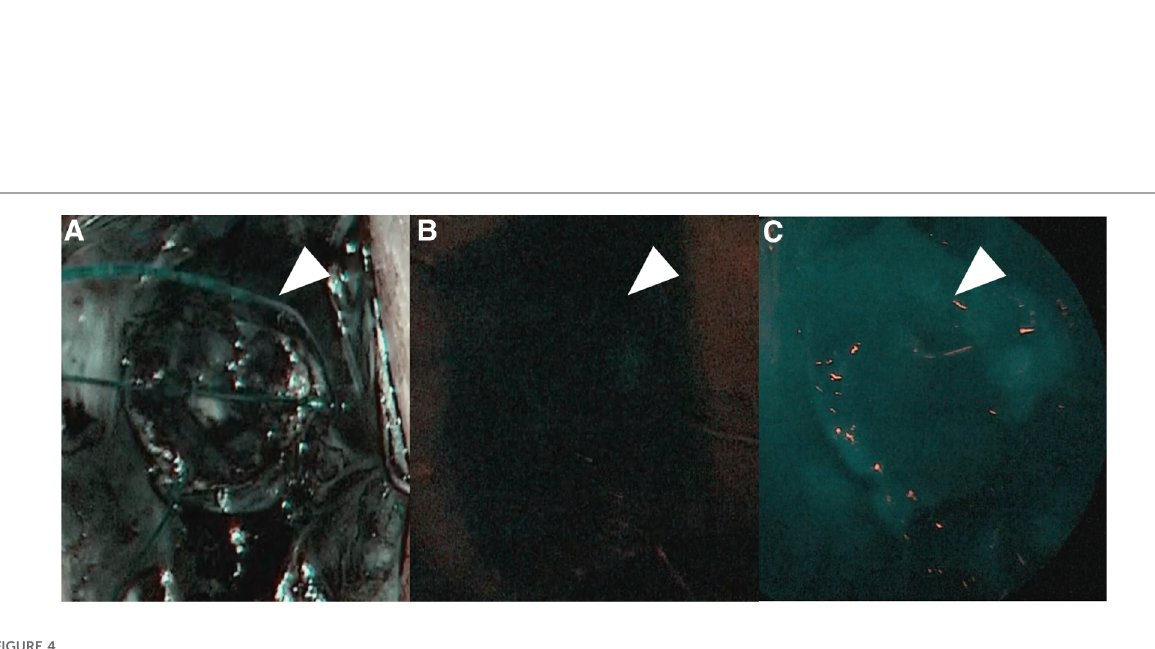
FIGURE 4 ( A ) Indocyanine green fl uorescence angiography was performed to assess the anastomotic perfusion (pre-injection). ( B ) ICG at a dose of 0.01 mg/kg was intravenously injected. ( C ) After con fi rming the J-pouch with good fl uorescence, ileal-J-pouch anal canal anastomosis was